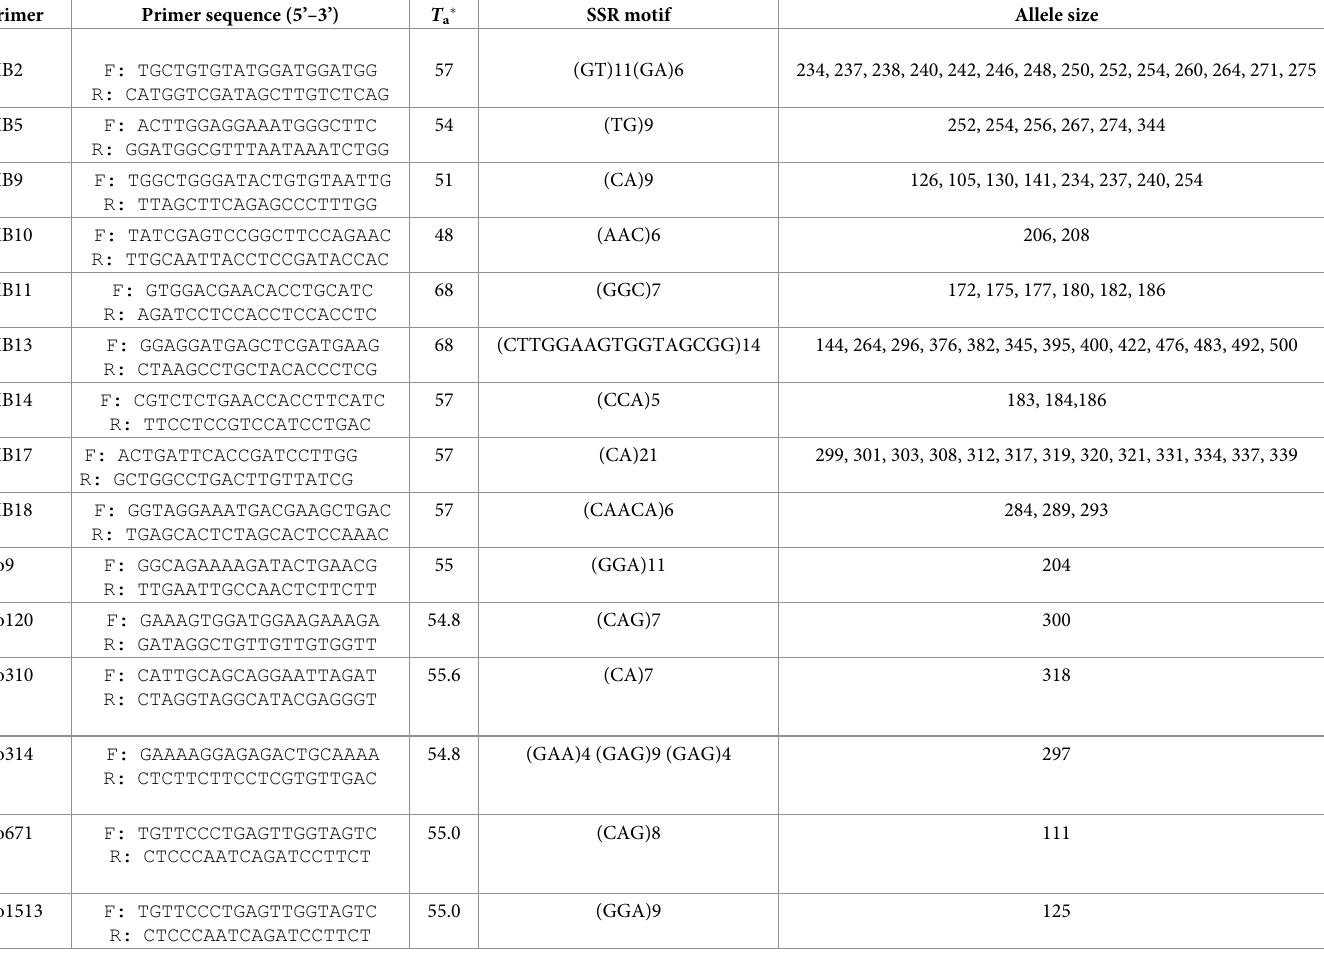
Table 2. Primer sequences, SSR motifs and allele sizes of 99 Fusarium oxysporum f. sp. niveum isolates. Primer Primer sequence (5’–3’) T a � SSR motif Allele